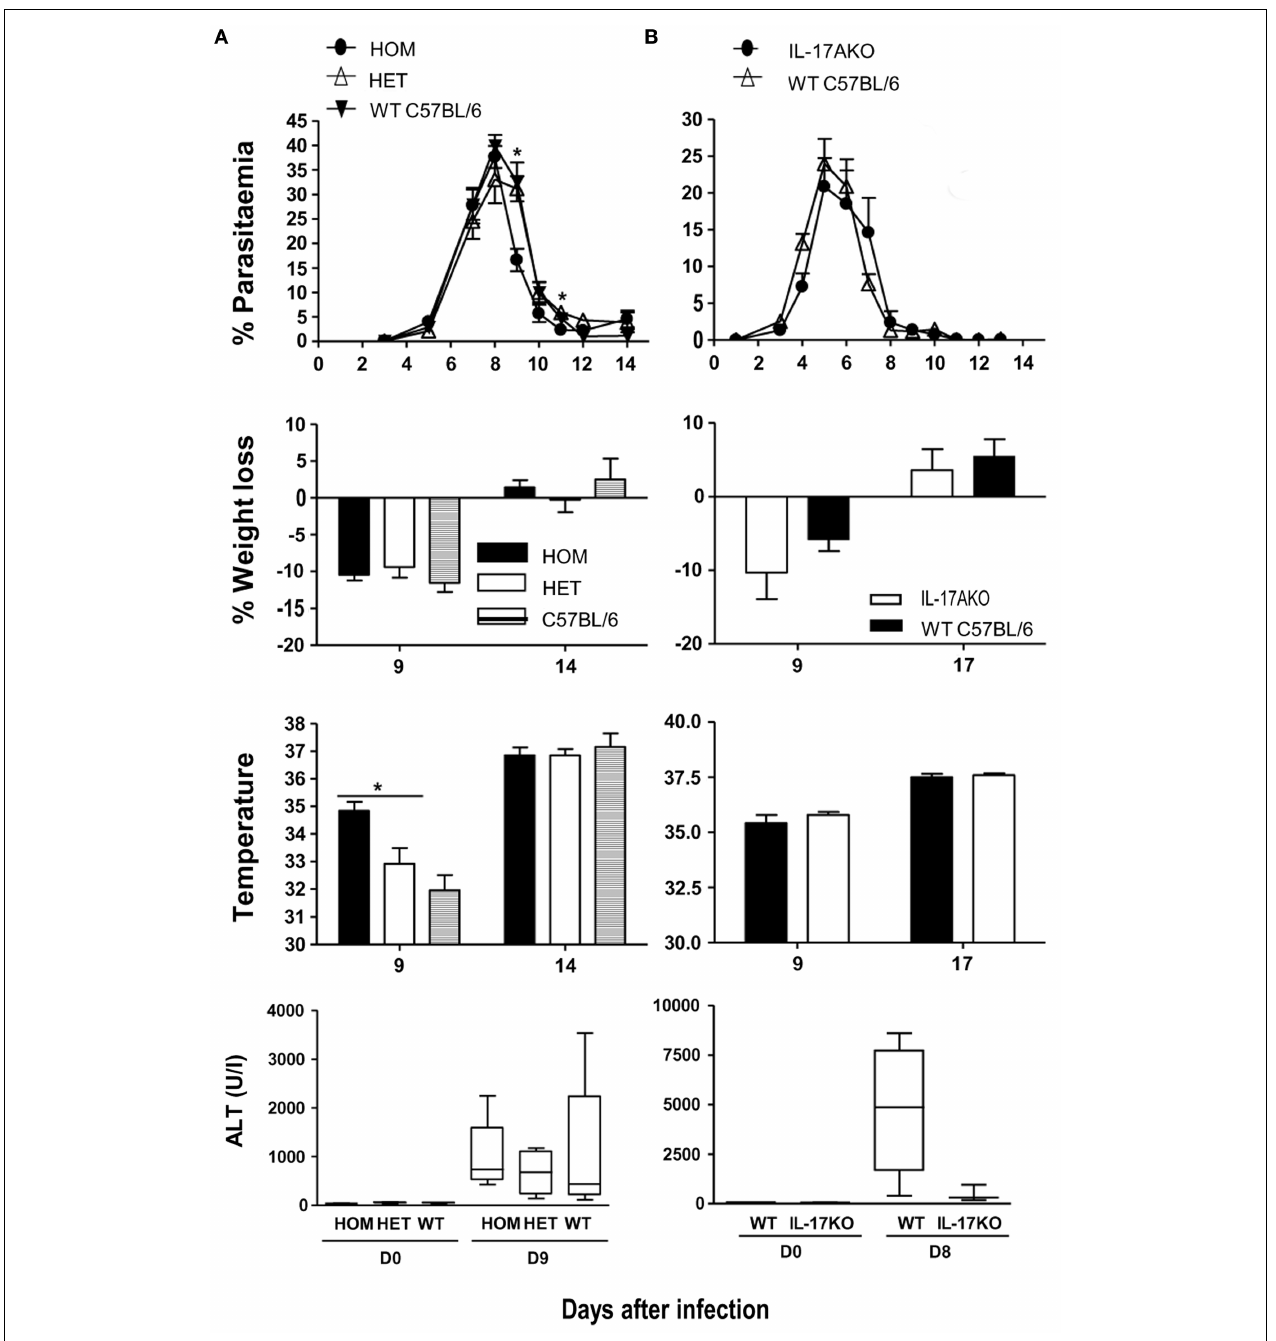
of the ALT substrate and incubated for 30min at 37˚C. Hundred microliters of 2,4-dinitrophenylhydrazine was then added and incubated a further 20min at RT. One milliliter of 0.4M NaOH was added to stop the reaction and the OD determined at 490nm.Water was used as blank. OD values were then converted into the equivalent enzyme units (U/ml) using a standard curve derived from known concentrations of a pyruvate standard.The standard curve for ALT was performed using pyruvate standards. Data are means and SEM of five mice and representative of two experiments. Significant differences are shown using a Mann–Whitney U -test of five mice [*significant P -value